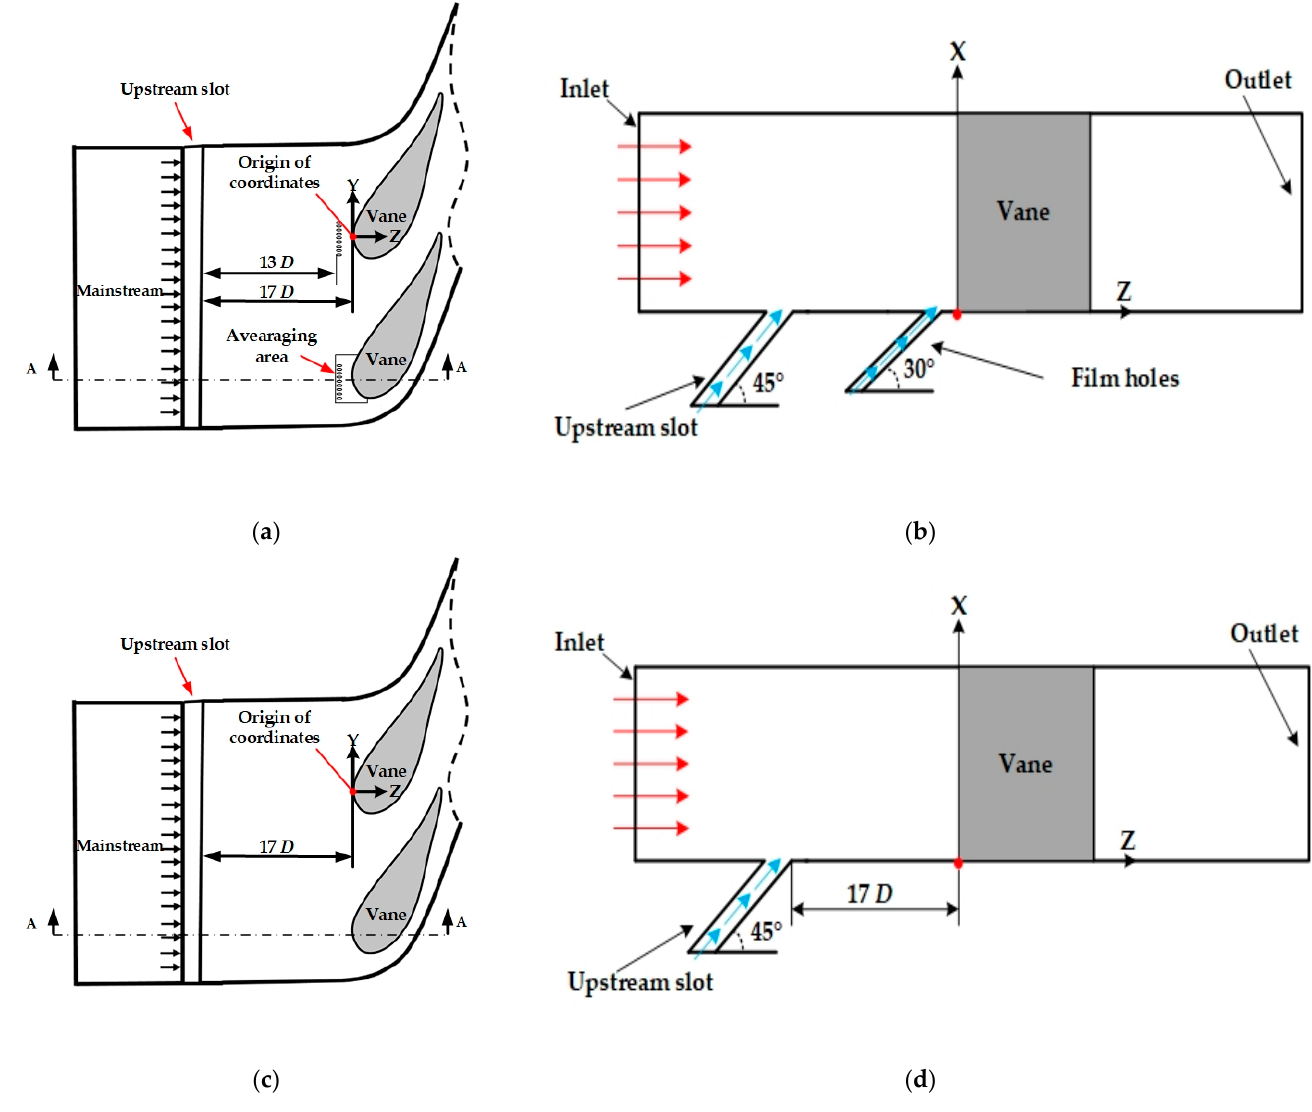
Figure 1. Schematic diagram of the vane with an upstream slot. ( a ) Experimental model. ( b ) A-A cross-section of the experimental model. ( c ) Computational model. ( d ) A-A cross-section of the computational model. Table 1. Geometric